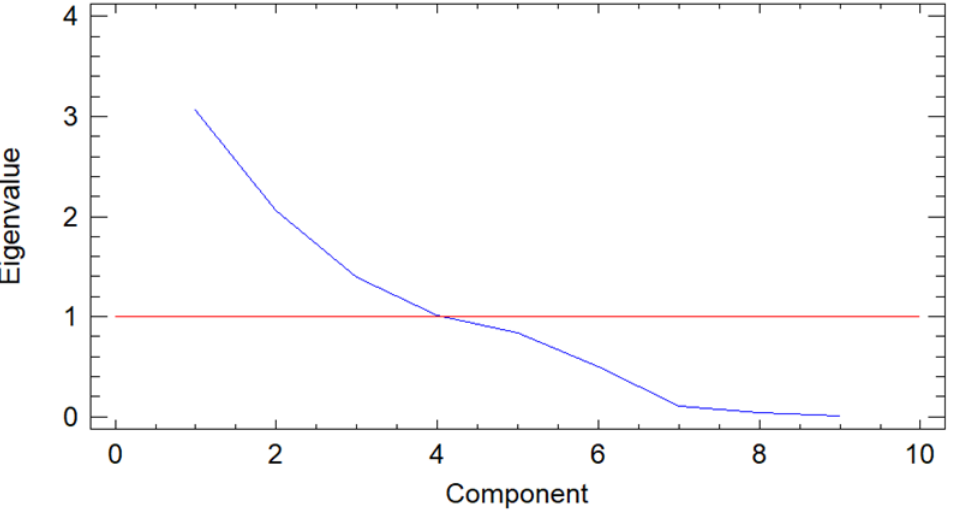
Figure 1. Screen plot of the principal component analysis (PCA) of soil characteristics between eigenvalues and principal components.